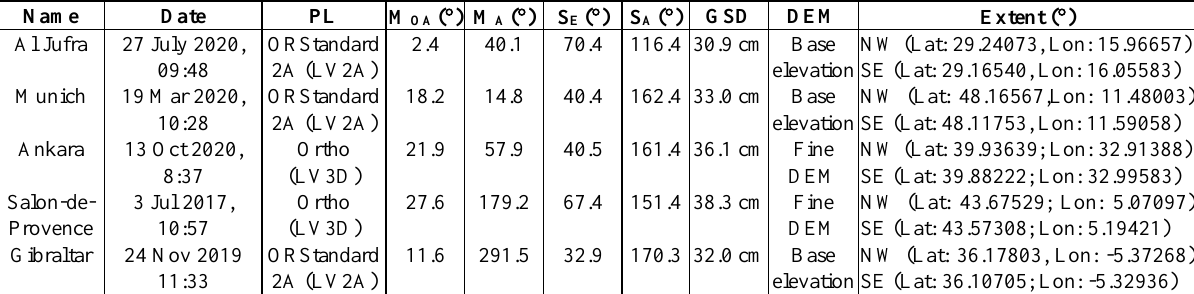
Table 1. The main specifications of the evaluated WV3 datasets.